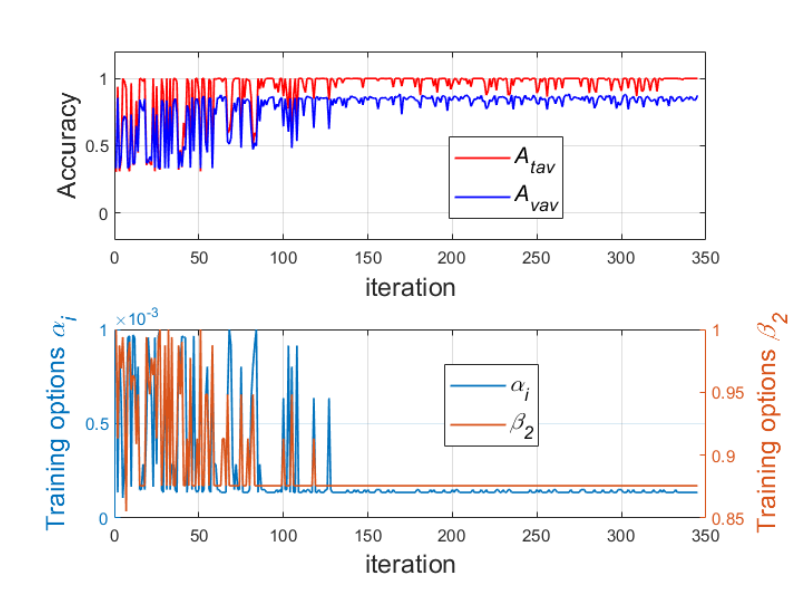
Figure 7. Changes of the average values of training A tav and verification A vav accuracies and the initial learning rate α i and the squared gradient decay rate β 2 of the RMSProp during the first 150 iterations of GA.